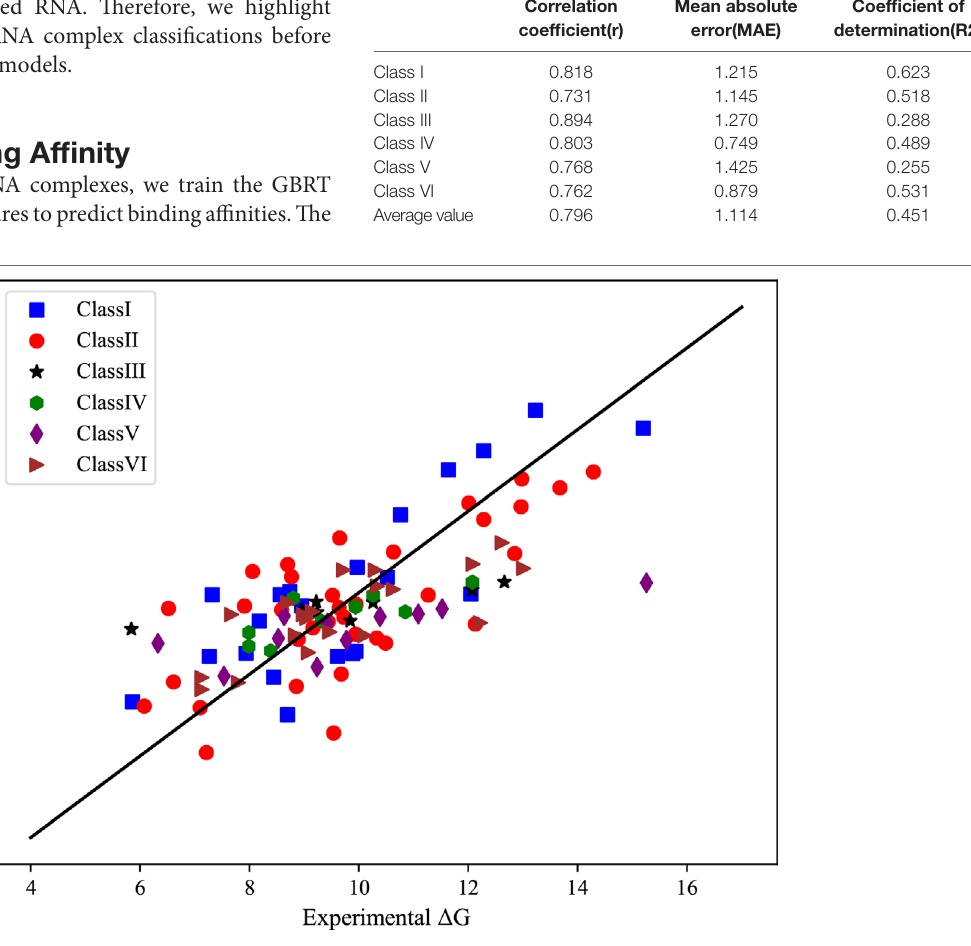
TABLE 3 | Performance measures of Pred PRBA on leave-one-outcrossvalidations. Correlation coefficient(r)